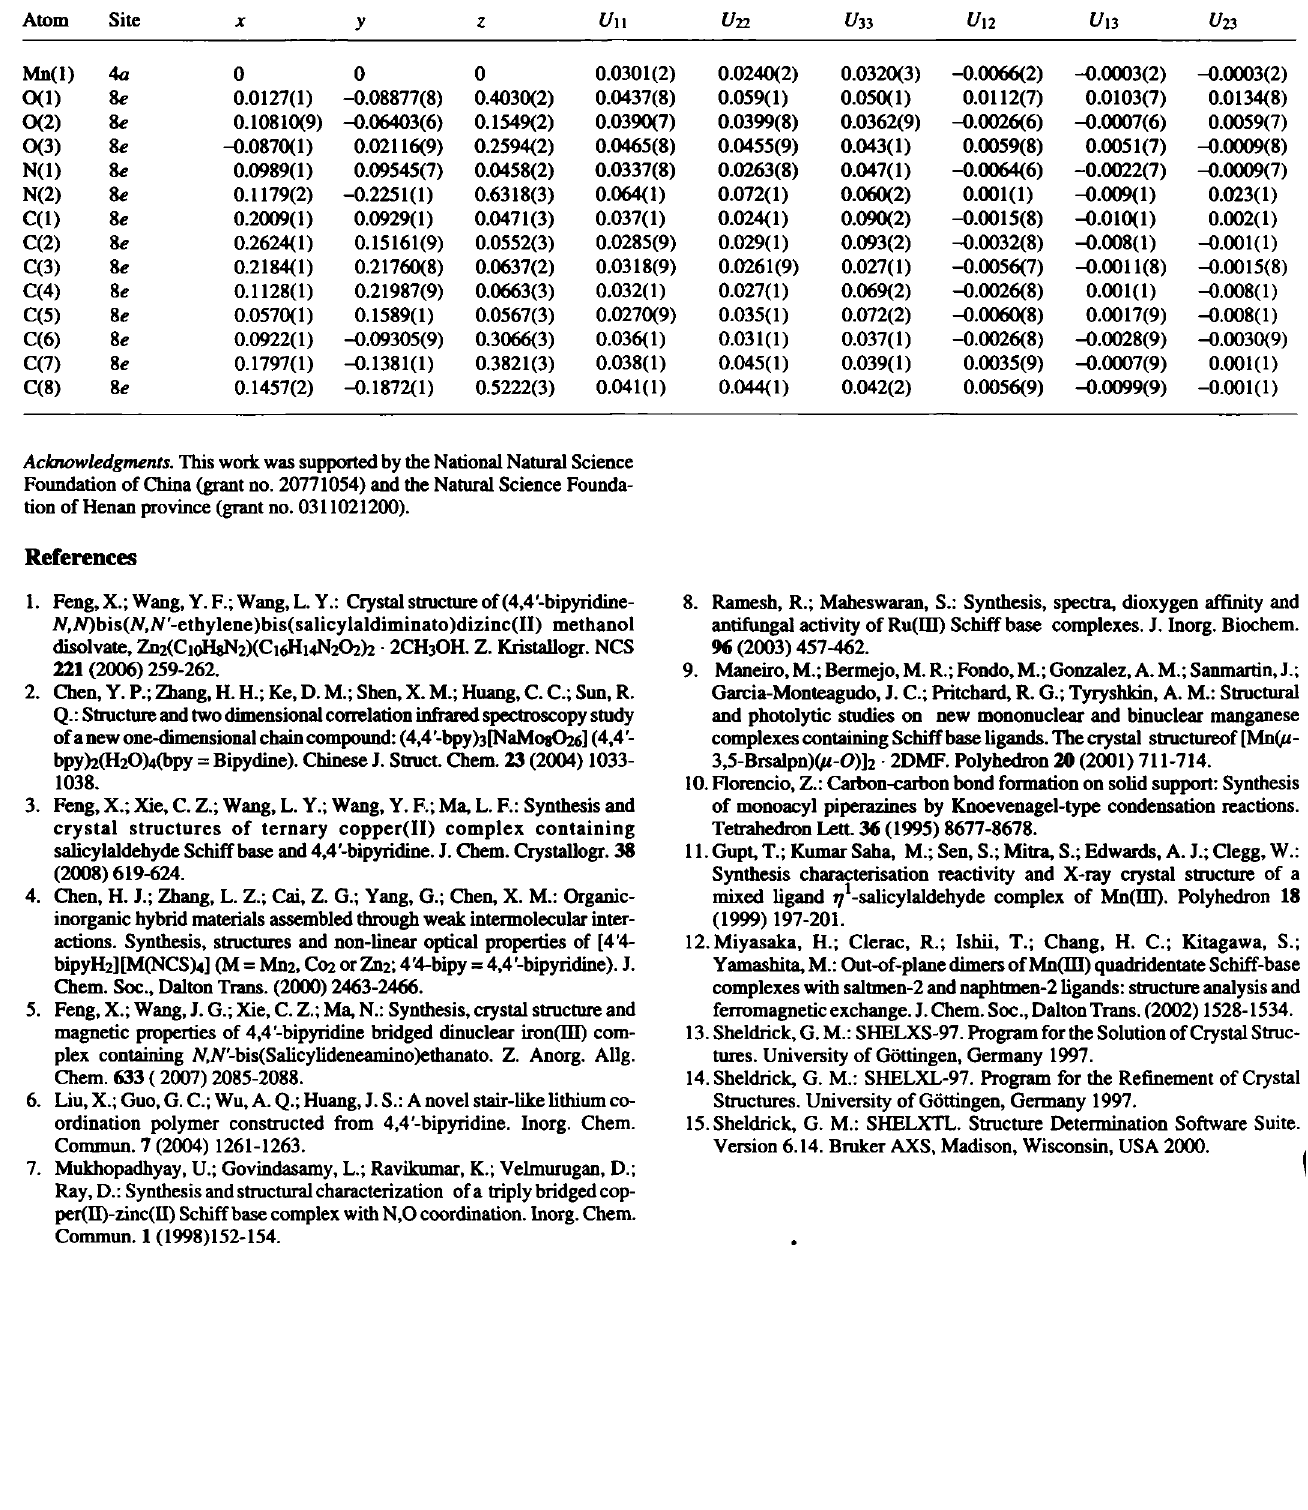
Table 3. Atomic coordinates and displacement parameters (in Â 2